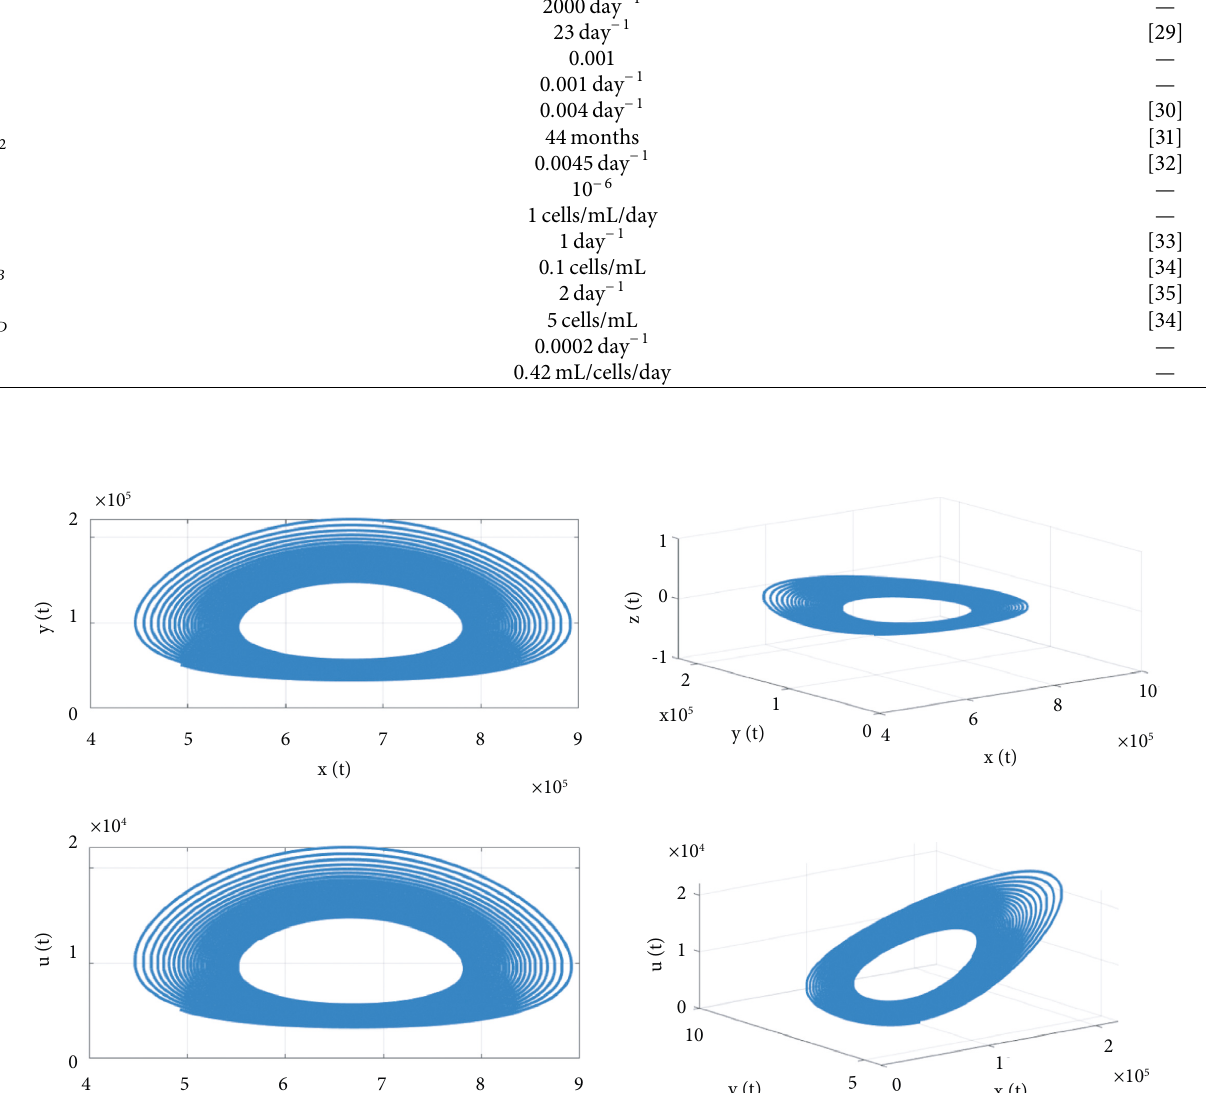
( t ) ≤ 0 . 6, the equilibrium is equilibrium. That is, for 0 ≤ ε equilibrium when τ < 0 . 93. The top left corner in the panel of 1 Figure 2 evidence the rate of change in healthy CD4+ and stable. For 1 . 5 × 10 − 7 ≤ β ≤ 1 . 5 × 10 − 6 , the equilibrium infected cells and the bottom left depicts the uninfected remains stable. When the transmission rate gets higher or cells and the free virions. Similarly, the phase portrait of lesser, it loses the stability of equilibrium, where α L , r , μ , all the cell populations such as uninfected and infected and a also affect the stability when it increases rapidly. cells with free virions and immune cells is accordingly The rest of the parameters are having less significance in ( t ) and the transmission picturized. The drug parameter ε terms of stability when compared with the remaining 1 parameters. rate β have a high influence on the stability of the